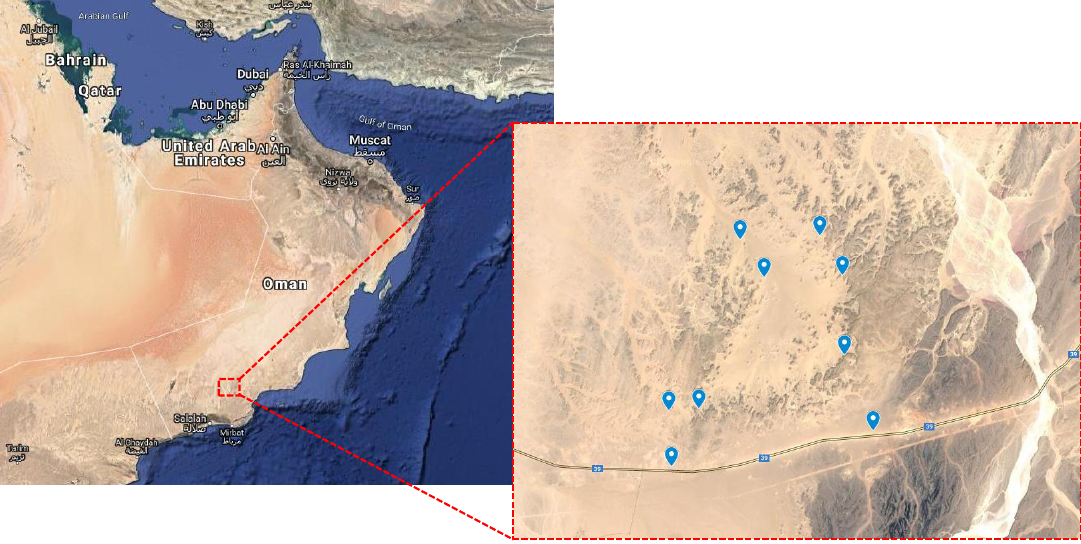
Figure 9. Location of the Dhofar Wind Project in Harweel, Sultanate of Oman [Google Maps].